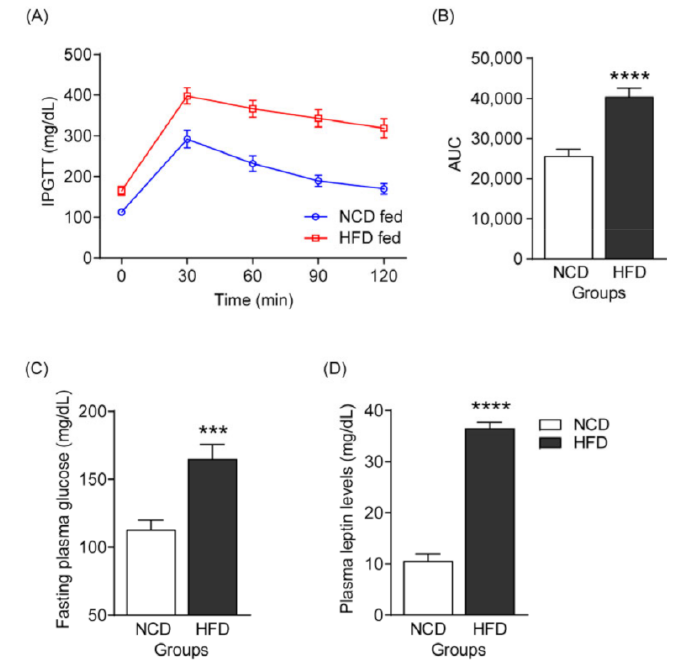
Figure 3. Establishing an HFD-induced NAFLD mice model by evaluating leptin resistance. ( A ) Intraperitoneal glucose tolerance test to evaluate leptin resistance after 10 weeks of feeding mice either an NCD or HFD. ( B ) The area under the curve corresponding to Figure 3A. ( C ) Fasting plasma glucose levels. ( D ) Plasma leptin levels. *** p < 0.001, **** p < 0.0001 vs. CMC. Data are shown as mean ±